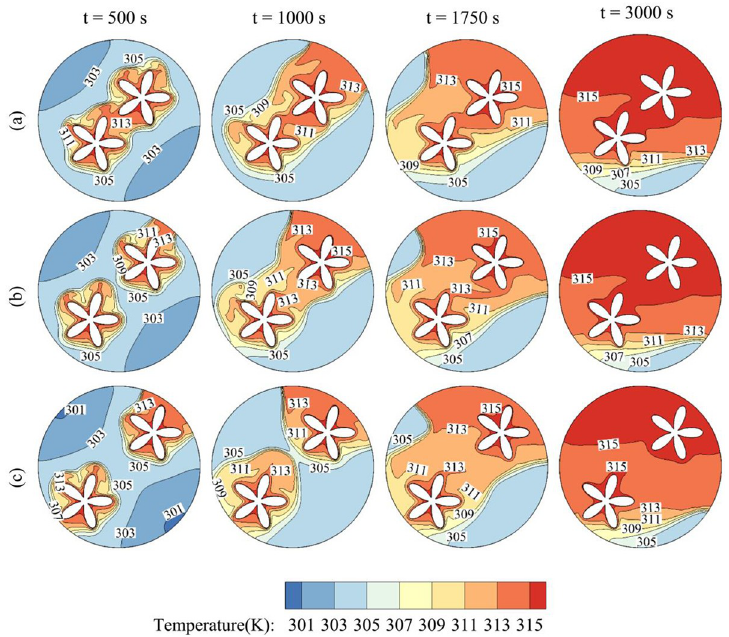
Fig 10. The contours of r 5, and η = π /4.